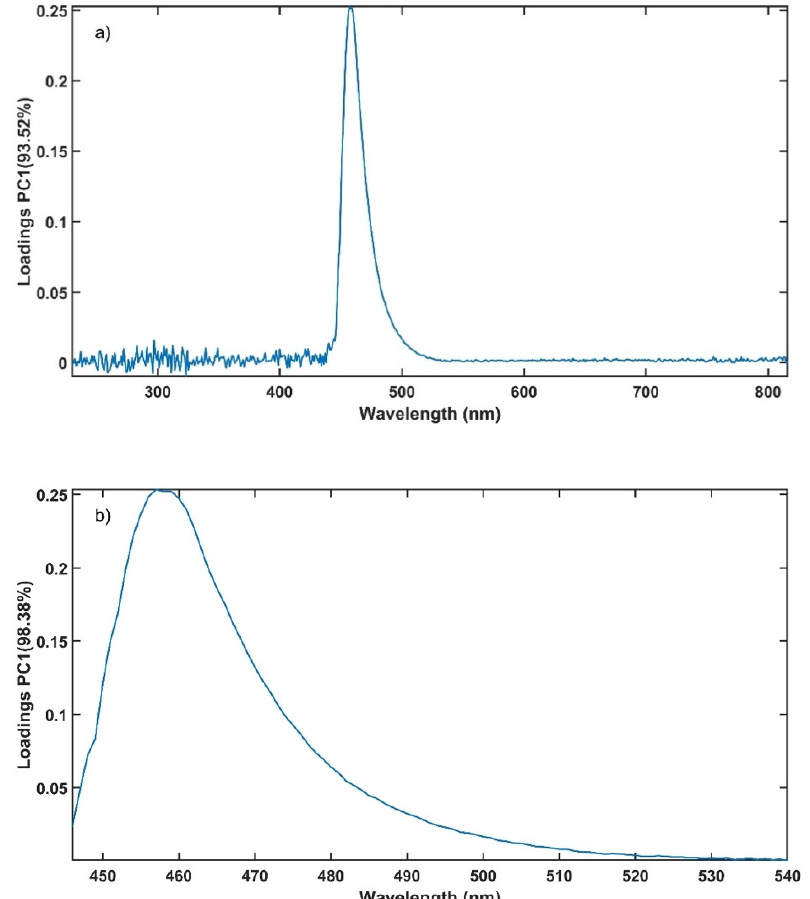
Figure 10. Loadings from a PCA of the calibration data set using ( a ) the entire wavelength range and ( b ) the selected range.